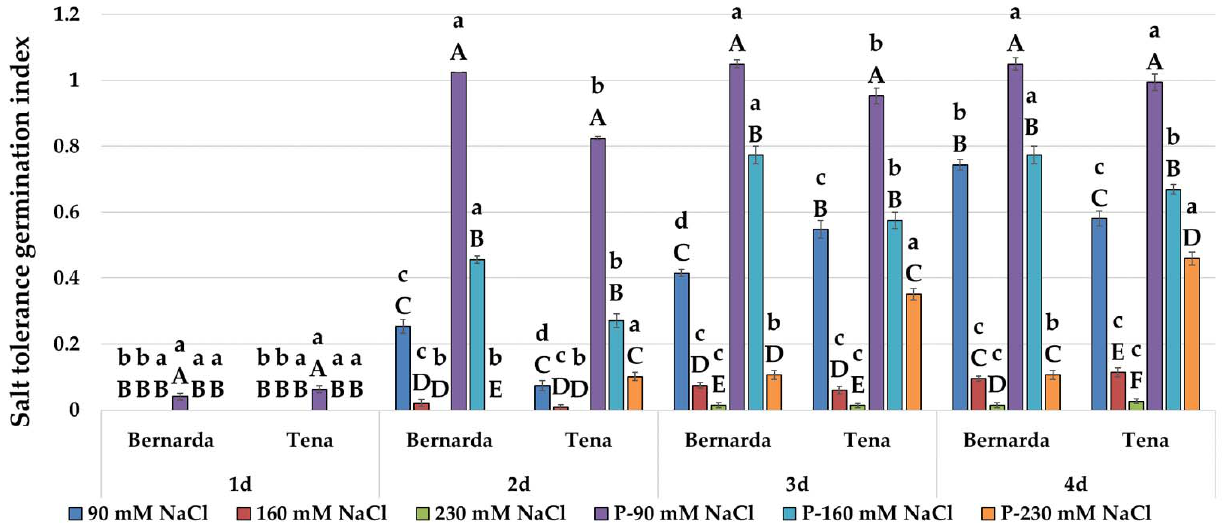
Figure 5. Salt tolerance germination index (STI_G) of two wheat genotypes during 4 days under salt treatments (90, 160 and 230 mM NaCl), high voltage electrical discharge (HVED) pretreatment (P) and combined (P-90 mM NaCl, P-160 mM NaCl and P-230 mM NaCl) treatments. Values are means of three repetitions (100 seeds/repetition) ± S.D. The different capital letters indicate significances among means of different treatments within the same genotype, while lowercase letters indicate significances among means between genotypes under the same treatment at p < 0.05 using LSD post